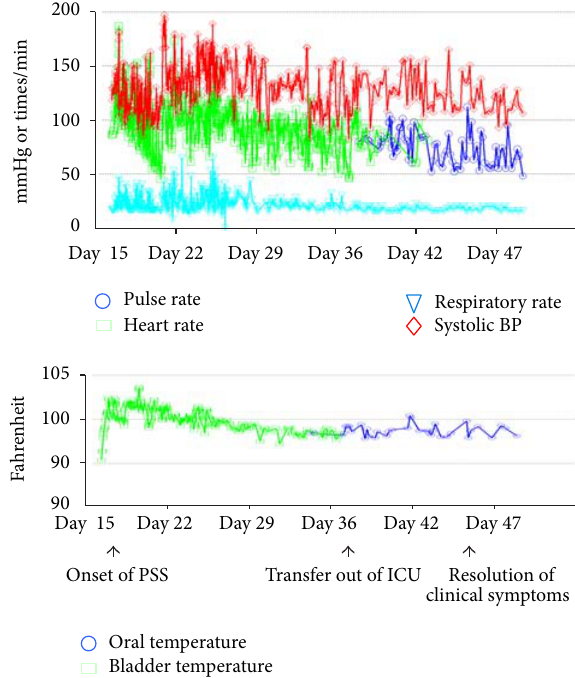
Figure 2: The evolvement of vital sign changes during patient’s hos- pitalization. The extent of changes in heart rate/pulse, temperature, respiratory rate, and systolic blood pressure during PSS episodes is shown throughout hospital